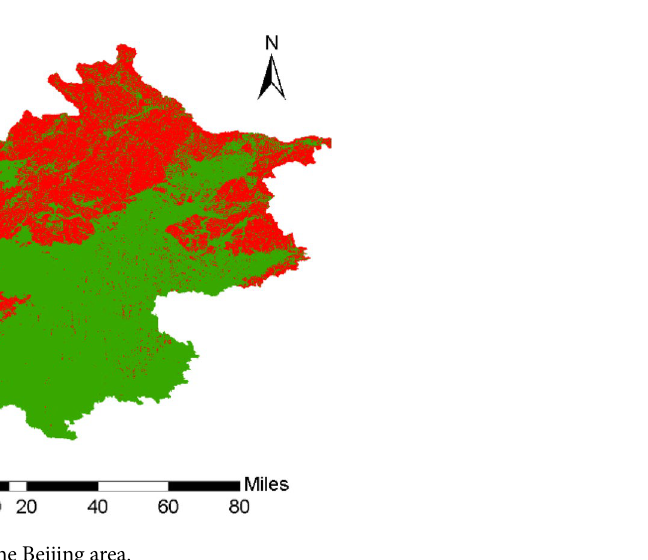
Figure 2. Slope classification in the Beijing